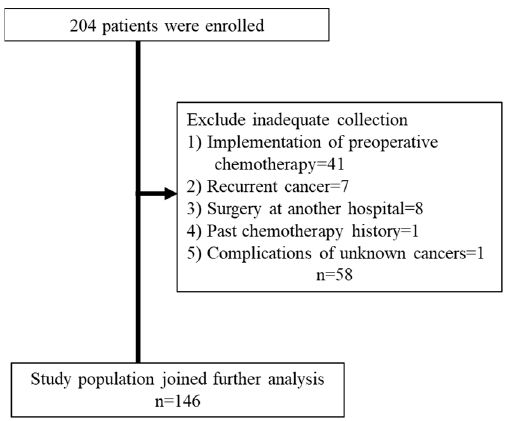
Figure 1. Participants selection flowchart .